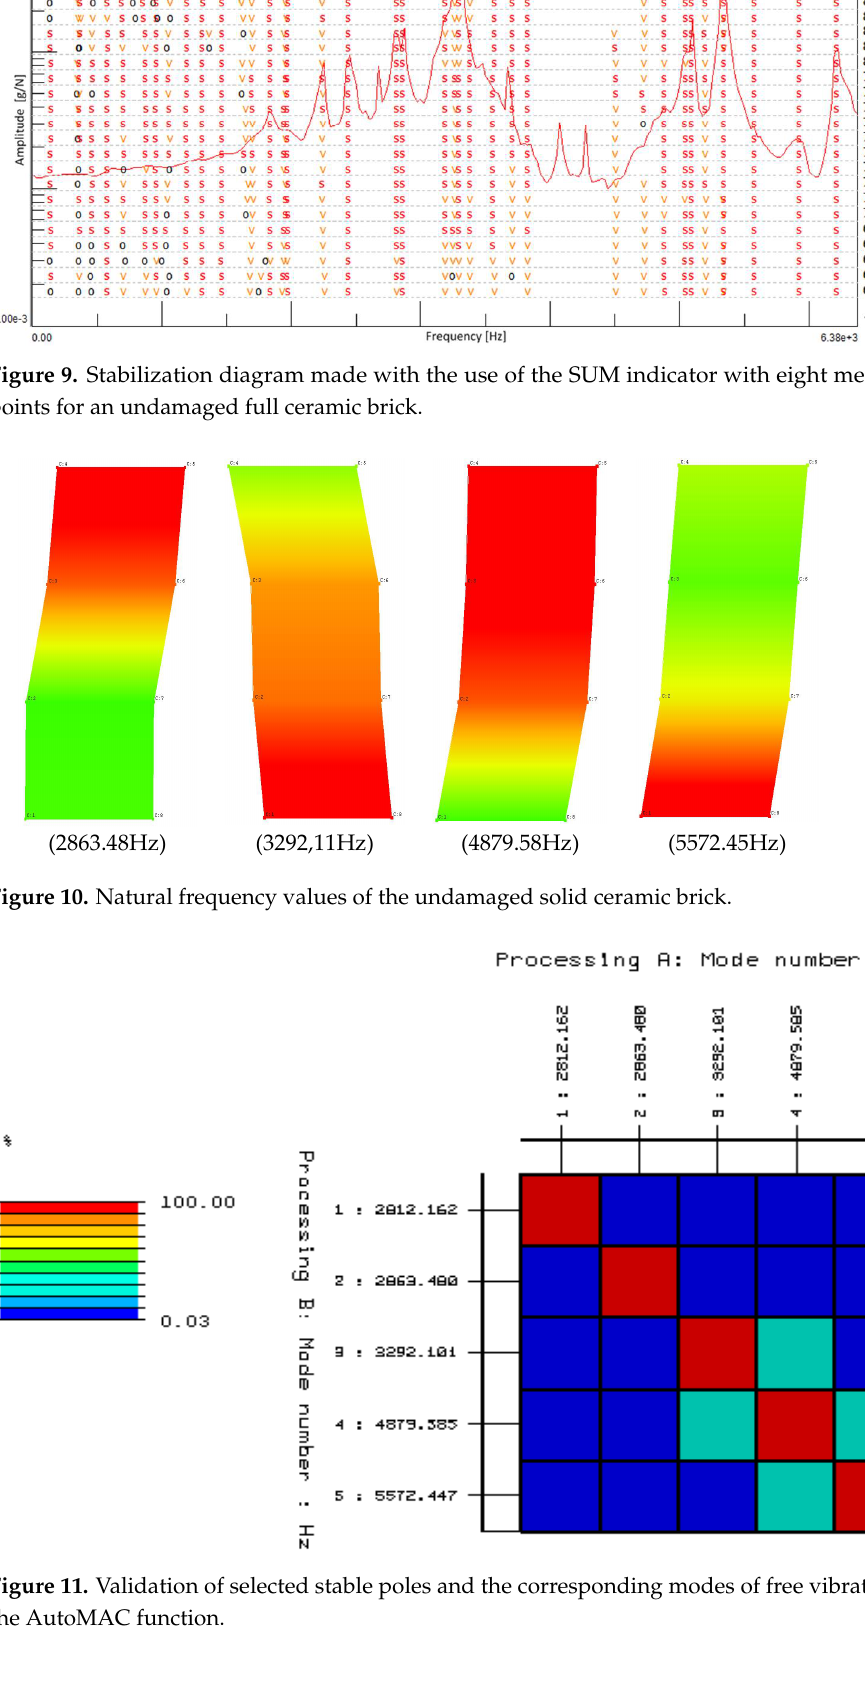
Table 2. List of natural frequencies and damping coefficients for undamaged solid ceramic brick.